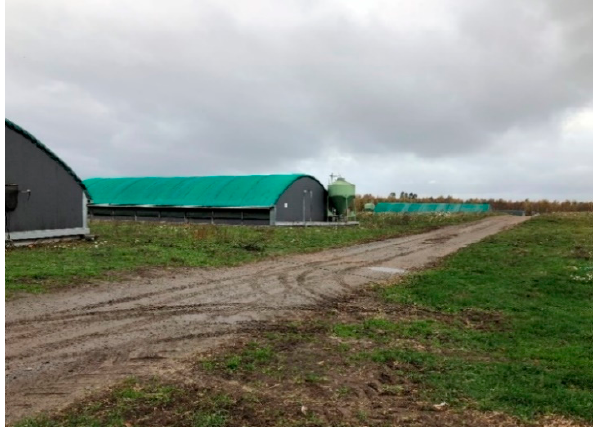
Figure 2. Mobile broiler houses on one Swedish organic farm.